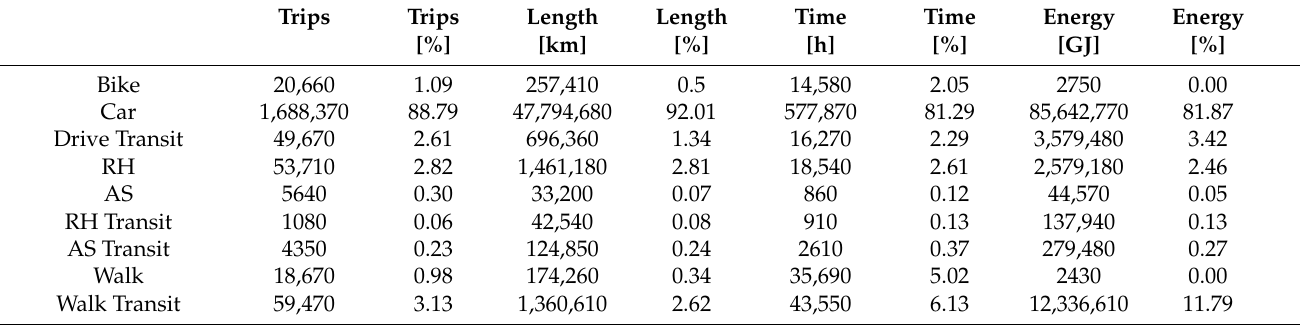
Table 2. Statistics of trips involving Santa Clara County in the developing scenario per transport mode used—interfered to the population; RH = ride hail, AS = automated shuttles.